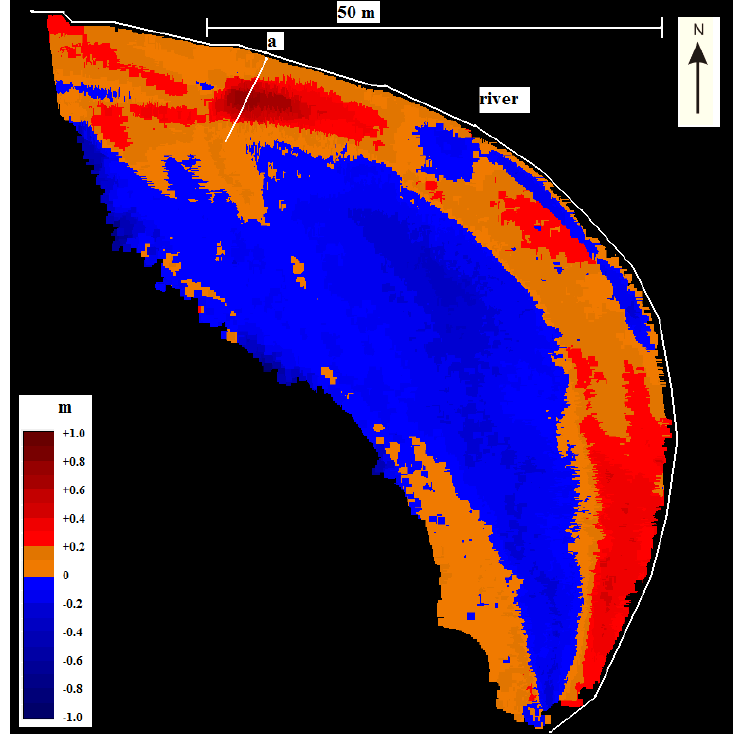
Figure 7. Deposition and erosion areas on Point Bar 2 between the years 2009 and 2008.